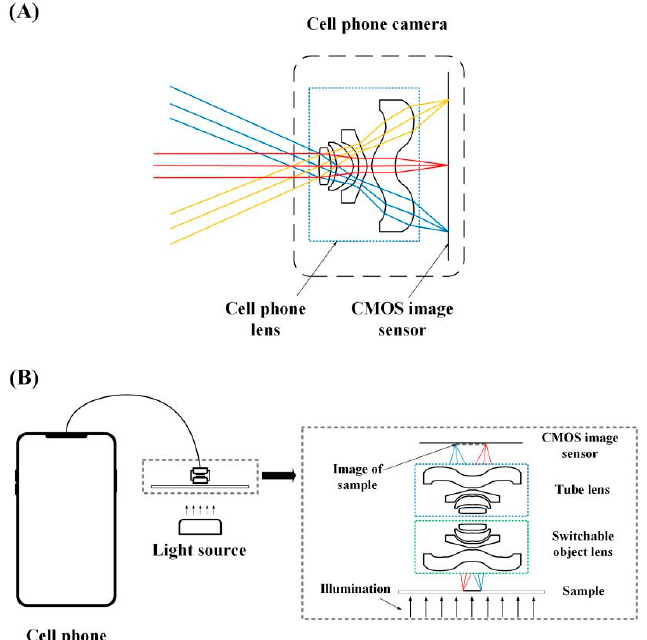
Figure 1. Principle of a miniature cell phone microscope. ( A ) Under normal circumstances, the cell phone lens can image a large field of view on a highly flat CMOS image sensor. This means that according to the principle of reversibility of light paths, high-quality microscopic imaging can be carried out when the cell phone lens is reversed. ( B ) Switchable reversed cell phone lenses are used as switchable objectives. They couple light from the sample through the tube lens and form the image of the sample on the CMOS image sensor. At last, the cell phone will process and display microscopic images. The microscope module is outside of the cell phone.